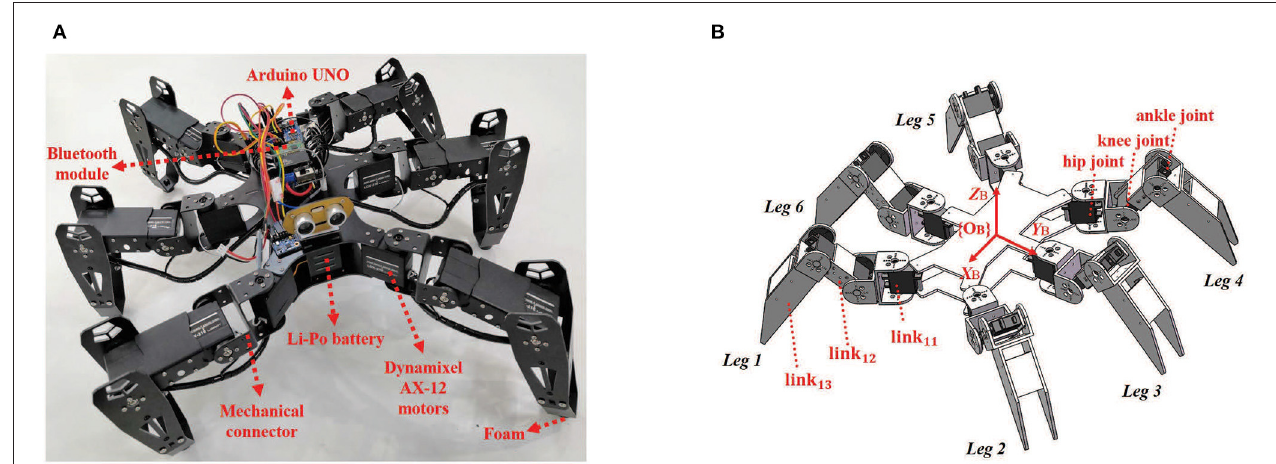
O B is the body frame whose origin is fixed on the body’s mass { }